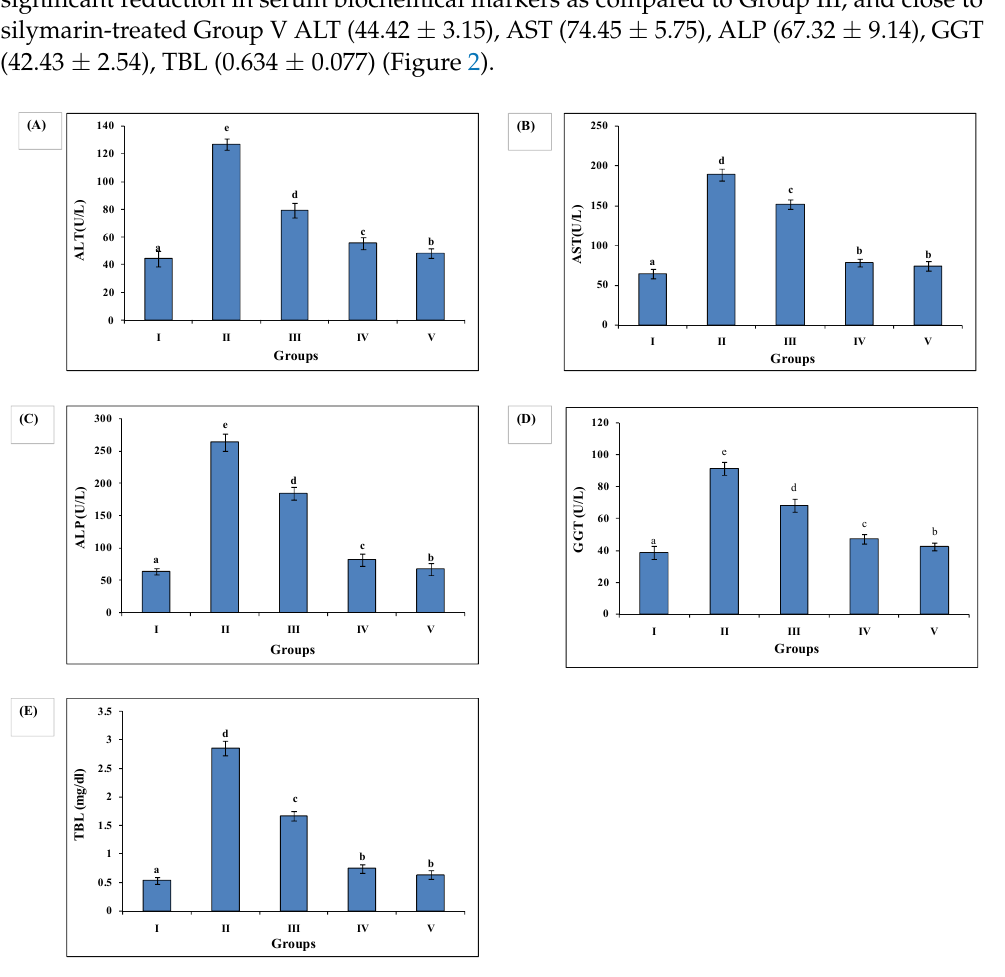
Figure 2. AAE maintained reduced levels of various biochemical parameters in Groups III and IV. ( A ) ALT (U/L), ( B ) AST (U/L), ( C ) GGT (U/L), ( D ) ALP (U/L), ( E ) TBL (mg/dL). All biochemical parameters were reversed by the test drug (AAE) administration in Groups III and Group IV, close to sylimarin-treated Group V, while Group II showed elevated levels. Duncan’s multiple-range test (DMRT) was used for the analysis of a significant difference between the means ( p < 0.05) and compared each parameter. Bars with the same letters are not significantly different. All values are means of five replicates ±